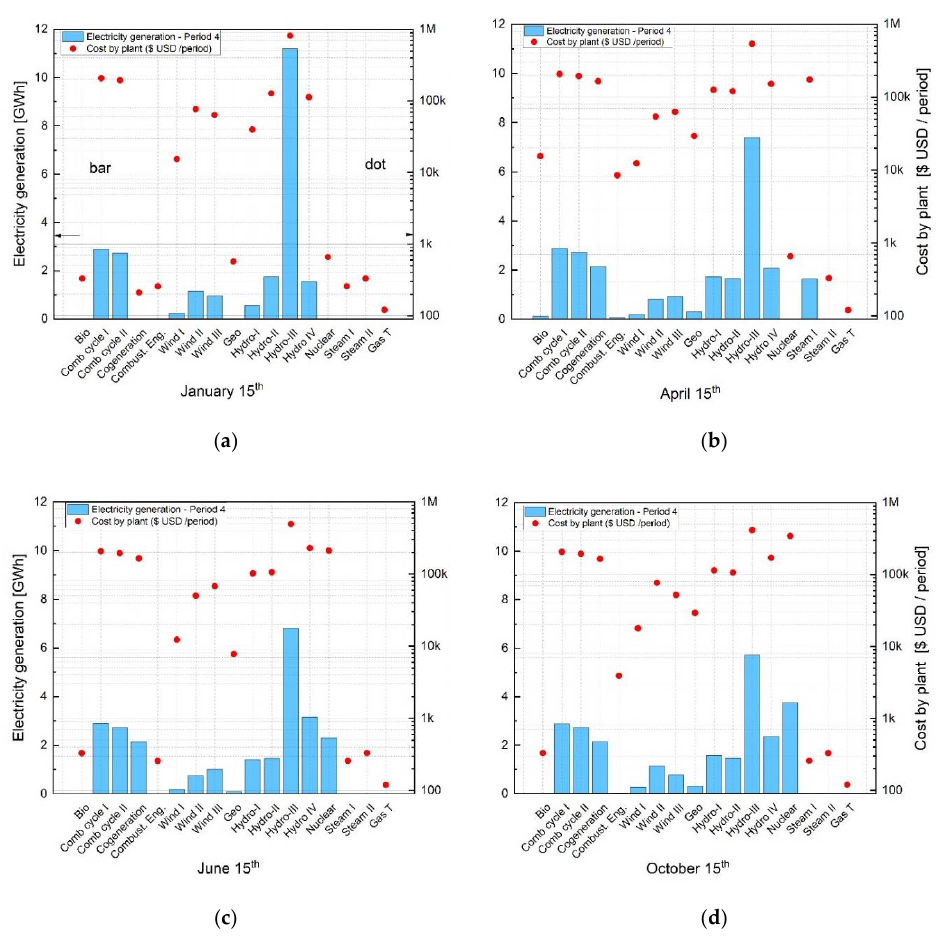
Figure 14. Electric power generation per plant and the associated costs during Period 4 for the four representative days of the year. ( a ) Winter day (15 January); ( b ) spring day (15 April); ( c ) summer day (15 June); ( d ) autumn day (15 October).